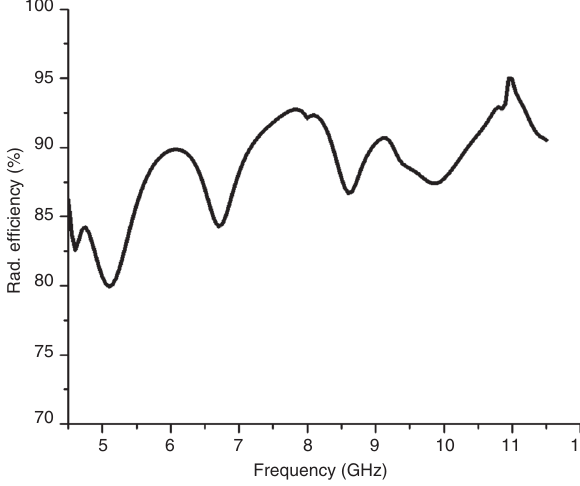
Figure 7 Simulated radiation efficiency of the proposed antenna